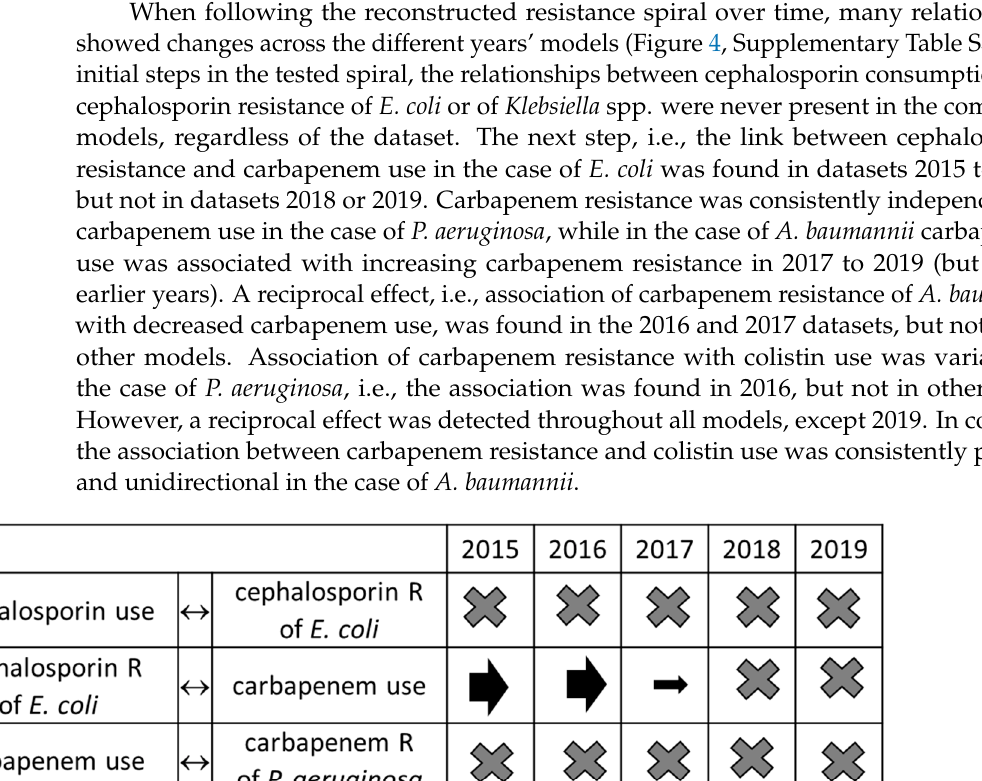
5 of 10 Figure 3. Changes in the relationships between antibiotic use and resistance over time: the example of the relationship between carbapenem resistance in P. aeruginosa and colistin use. Left panel: im- pulse response functions with incidence densities of infections by carbapenem-resistant P. aeru- ginosa per 1000 occupied bed-days as impulses and colistin consumption (defined daily doses per